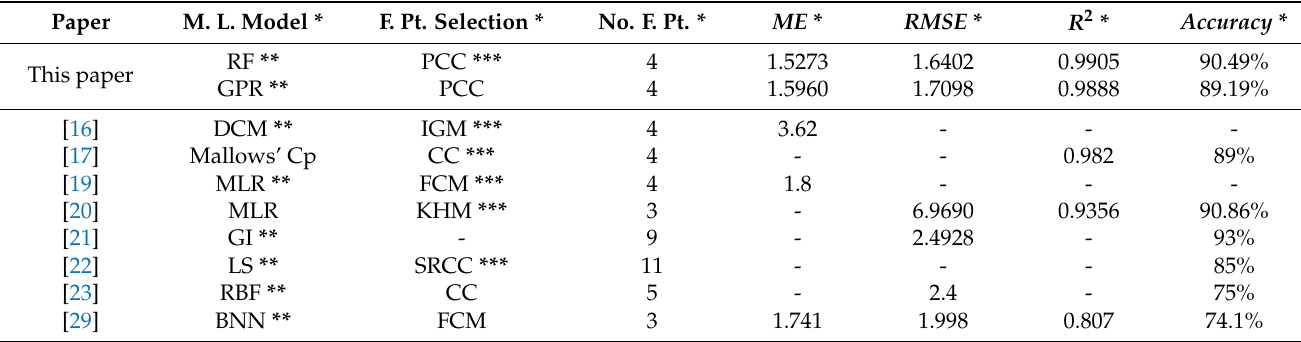
Table 5. Comparison of this paper with published literatures. Note that the prediction performance indices of this paper are under the variable speed condition, while most of the other literatures are under specific constant speed conditions based on their own